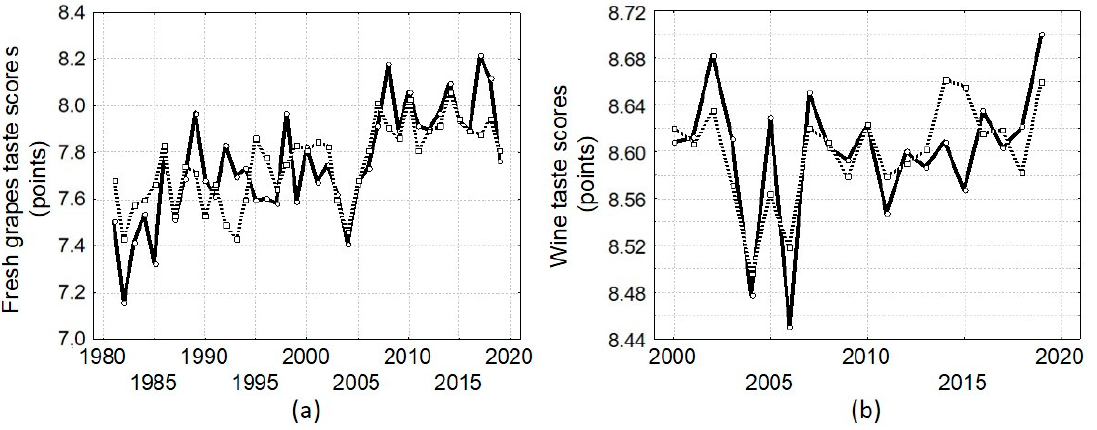
Figure 4. Verification of taste scoring models for: ( а ) fresh grapes; ( b ) wine. Designations: solid line— actual values, dotted line—calculated values.